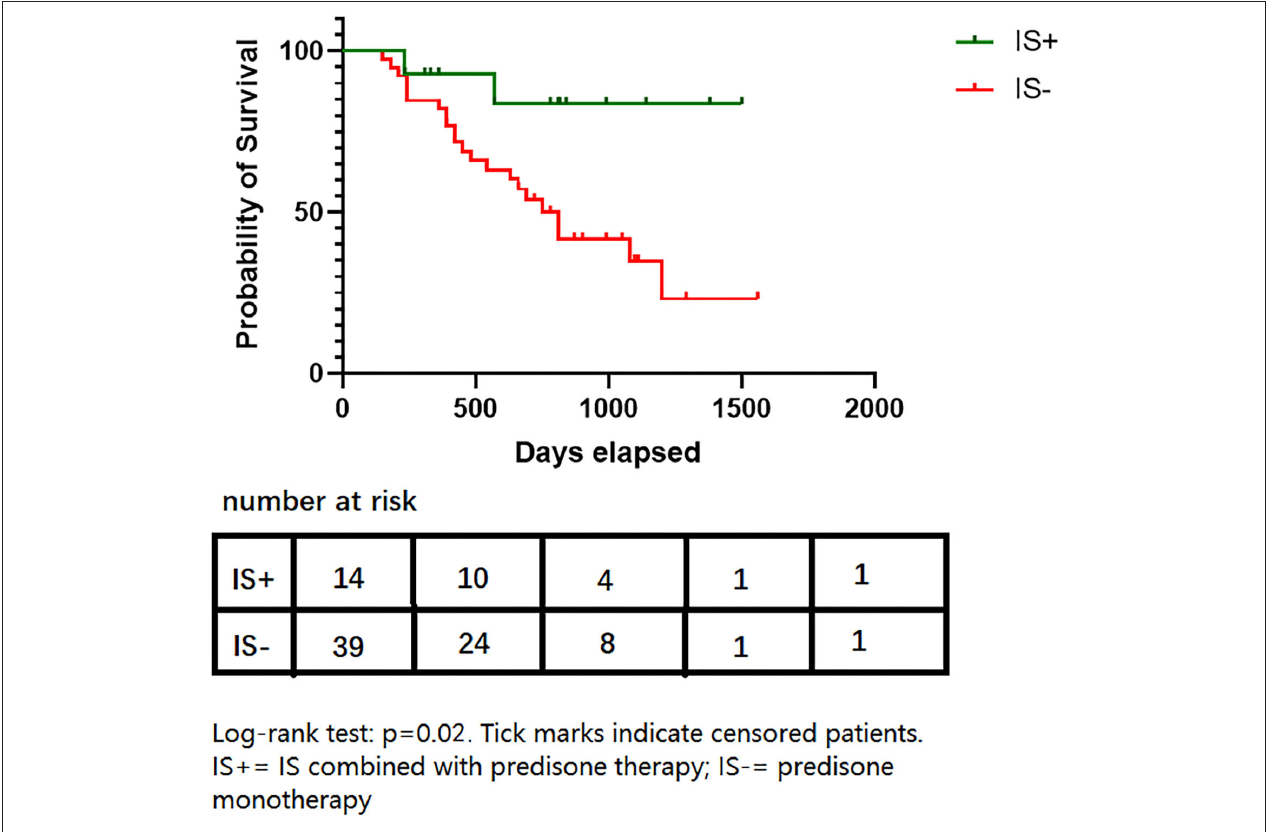
FIGURE 2 | Survival proportions of two groups. Log-rank test: p = 0.02. Tick marks indicate censored patients. IS + , IS combined with prednisone therapy; IS-, prednisone monotherapy.